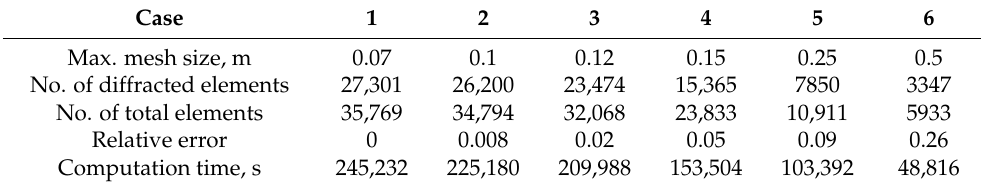
Table 3. The specifications of mesh convergence study for pitch